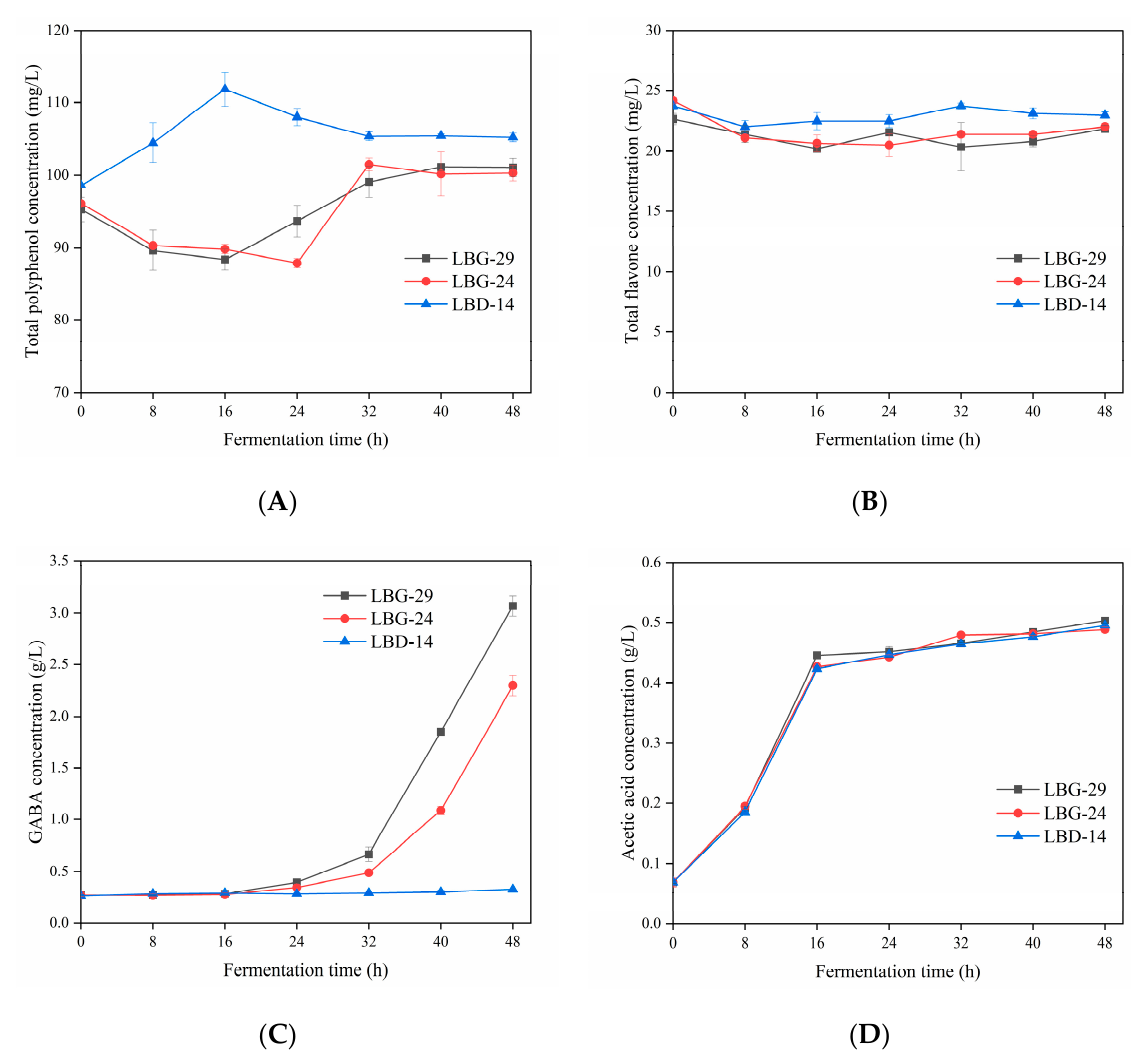
Figure 5. Fermentation time dependence of the total polyphenol ( A ), total flavonoid ( B ), GABA ( C ), and acetic acid ( D ) contents. Values are the means ± SD.